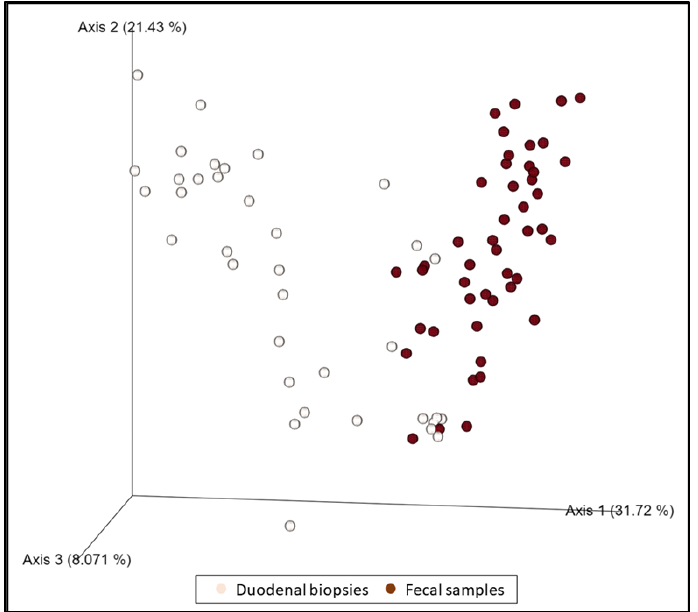
Figure 3. The dimensional representation of principal coordinate analysis (PCoA) plots of weighted UniFrac distances of 16S rRNA genes. Fecal samples were separated from duodenal samples (PER- MANOVA, p = 0.001, pseudo – F: 17.39).